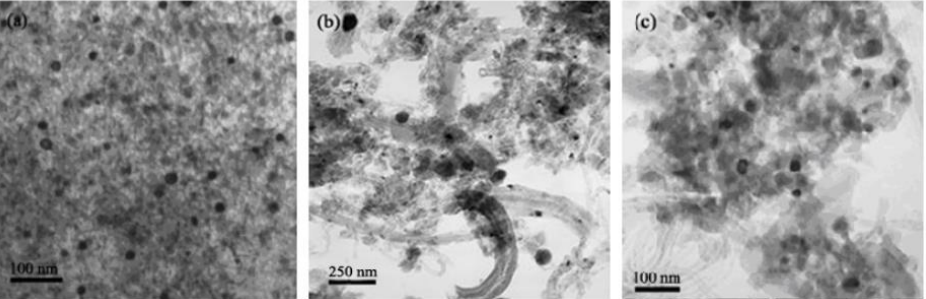
Figure 6. TEM images of catalyst after reaction [66]: ( a ) Ni/La 2 O 3 /γ-Al 2 O 3 ; ( b ) Ni/La 2 O 3 /Al 2 O 3 ; ( c ) Ni/La 2 O 3 /α-Al 2 O 3 .